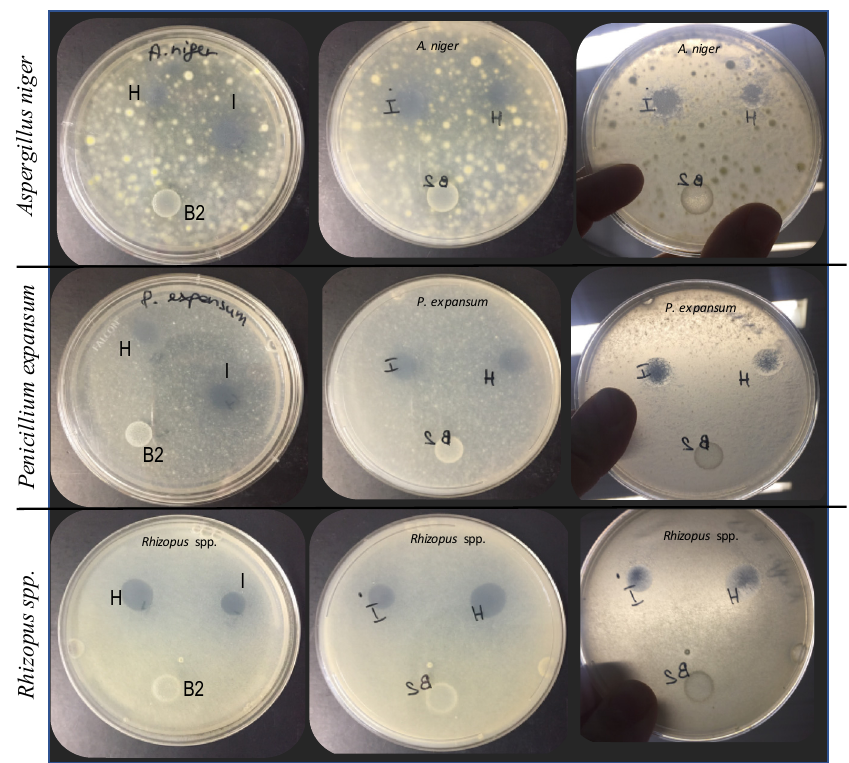
Figure 3. Mycelial growth inhibition of nanoformulations of lemon grass essential oil at different concentrations against Aspergillus niger , Penicillium expansum and Rhizopus spp. after 3 days of incubation at 25 °C. B2 = control spot containing Alg/tween; H = spot of nanoformulations with 1.5% LEO, I = spot of nanoformulations with 2% LEO. The first column shows the front side of the Petri dish, the second and third columns show the back side of the Petri dish.